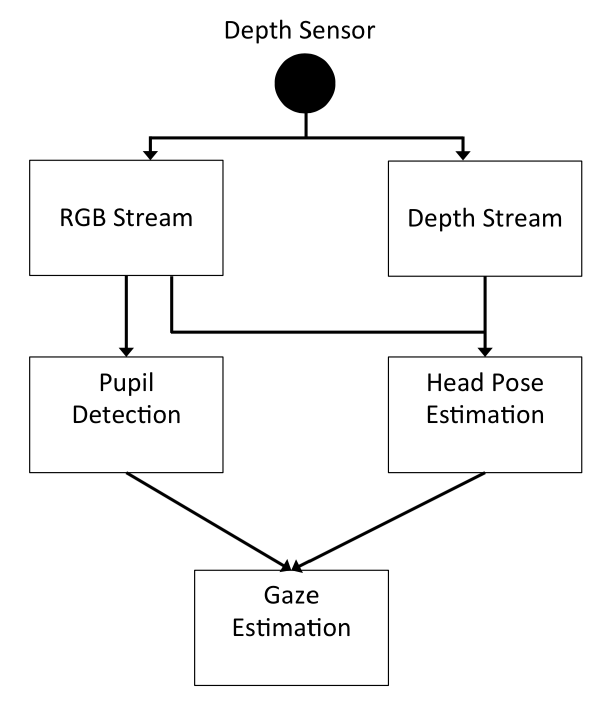
Figure 1. A block diagram of the gaze estimation